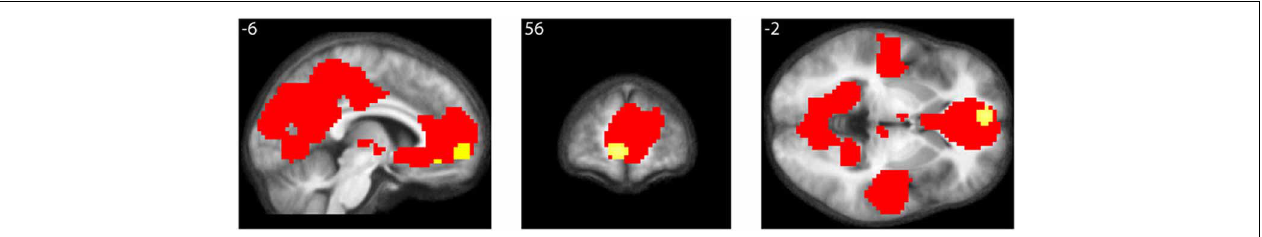
FIGURE 4 | Conjunction of activations with beauty rating and de-activations with equations. Conjunction-Null of two contrasts, “Parametric beauty rating” and “De-activations with Equations,” both